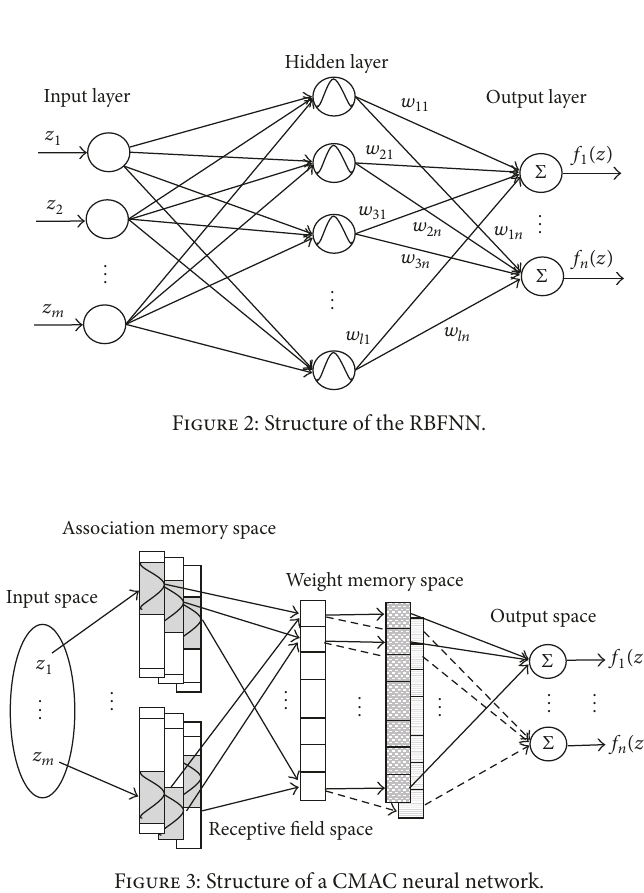
Figure 3: Structure of a CMAC neural